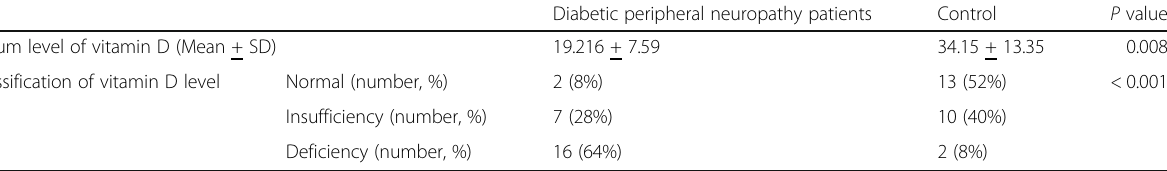
Table 4 Comparison between diabetic peripheral neuropathy patients and healthy controls regarding serum level of vitamin D Diabetic peripheral neuropathy patients Serum level of vitamin D (Mean + SD)